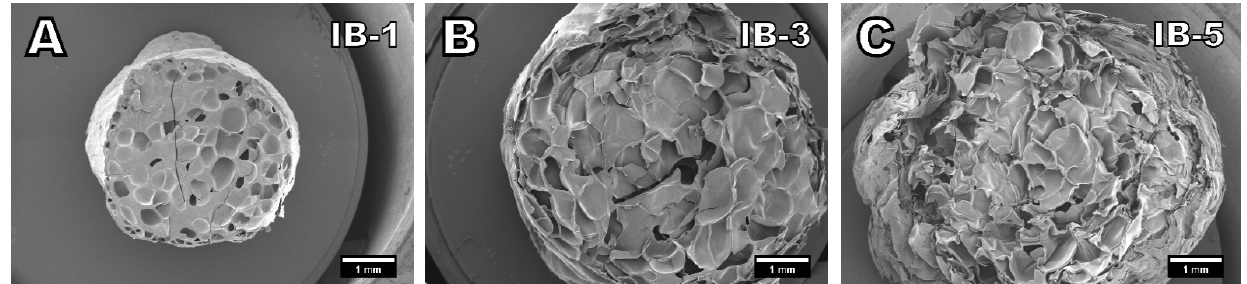
Figure 2. Side profiles of produced cellulose palmitate foams: ( A ) IB-1, ( B ) IB-3, ( C ) IB-5, ( D ) CO 2 -0.5, ( E ) CO 2 -1, ( F ) CO 2 -